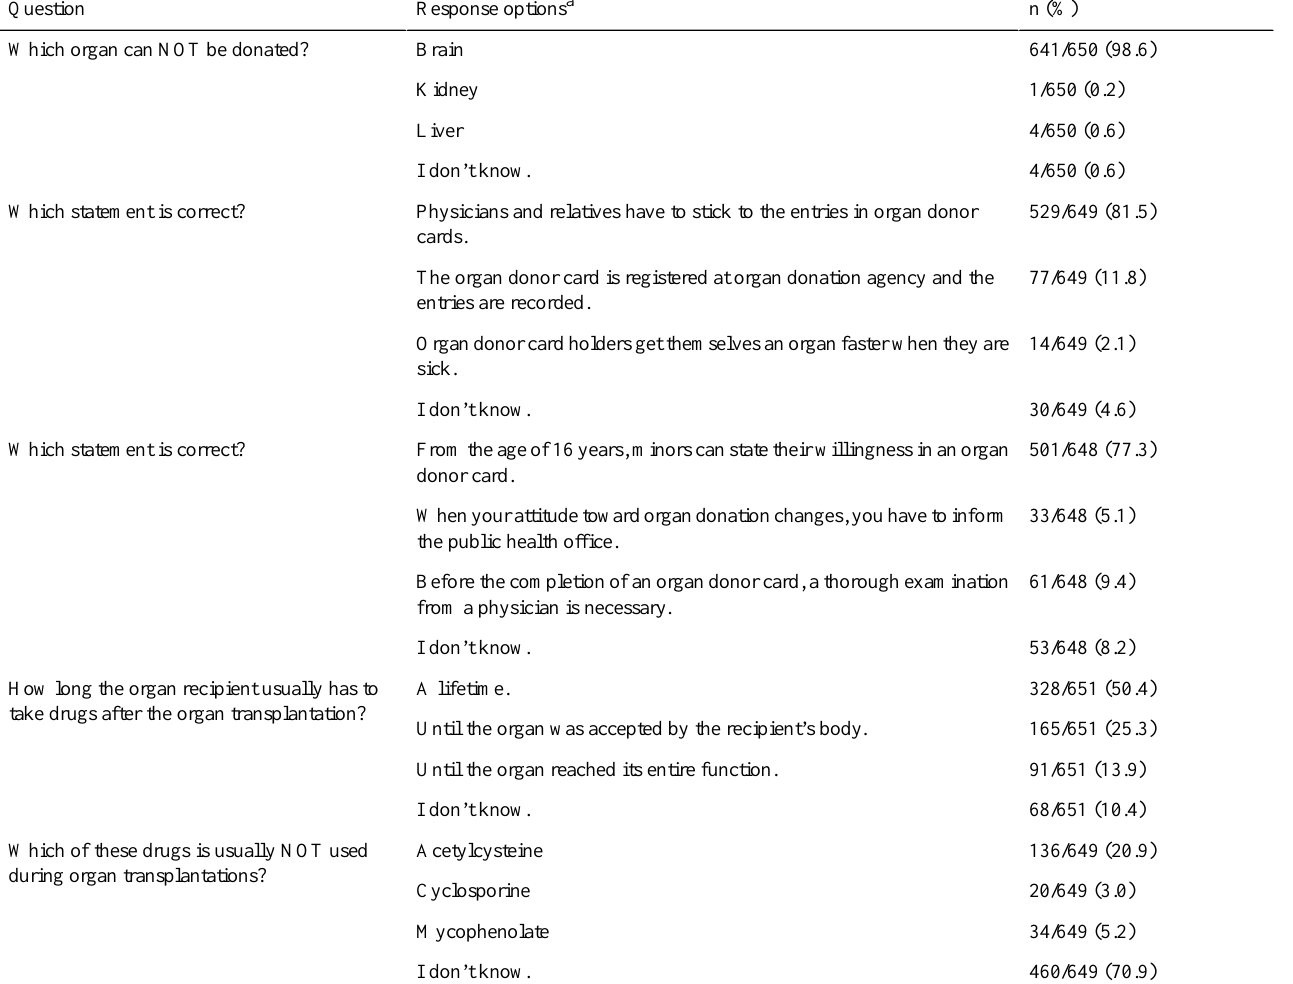
Table 1. Exploration of specific knowledge using five factual questions, organized by level of